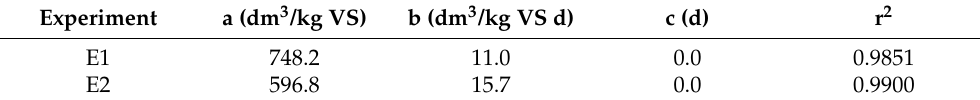
Table 7. The estimated model parameters and unit simulation of biogas accumulation for 60 days.